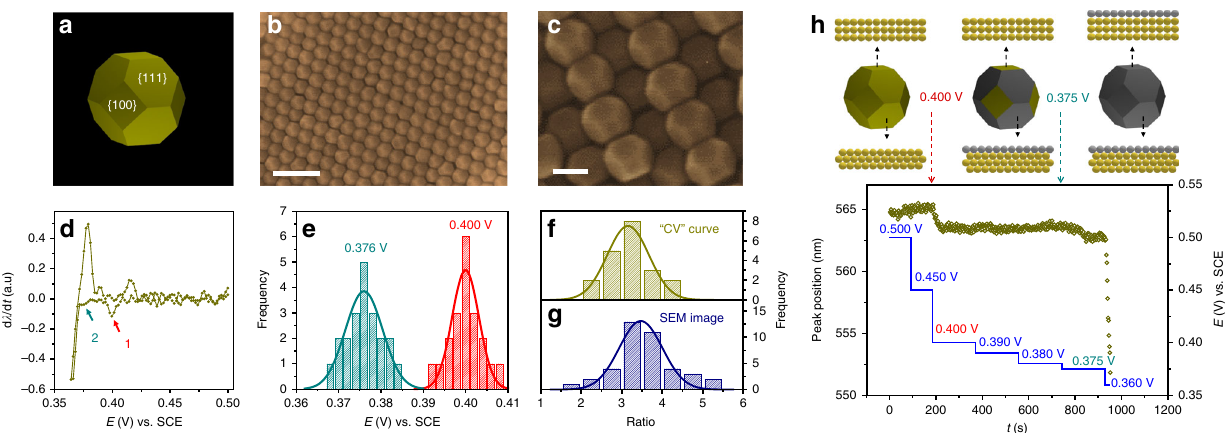
Fig. 4 Study of Ag electrodeposit on truncated octahedral Au nanocrystals. a A schematic of truncated octahedral Au NC showing the structural details. SEM images of truncated octahedral Au NCs coated on the electrode obtained with b high and c low magni fi cation, showing a highly ordered structure. d The optical “ CV ” of a single truncated octahedral Au NC reconstructed using the spectral shift of the scattering spectra at different potentials. e The peak potential statistics of UPD bands of {111} (red) and {100} (dark cyan) facets on the truncated octahedral Au NCs obtained from the optical “ CV ” s of 20 individual NCs. f – g The distribution of the area ratio of {111}/{100} on different individual NCs estimated from f the optical “ CV ” s and g SEM image. h The time-dependent peak position change of the scattering spectra of a single truncated octahedral Au NC under different potential controls, along with the corresponding schematics showing UPD processes on different facets (top graphs). The scale bars are 200 nm in b and 50 nm in c